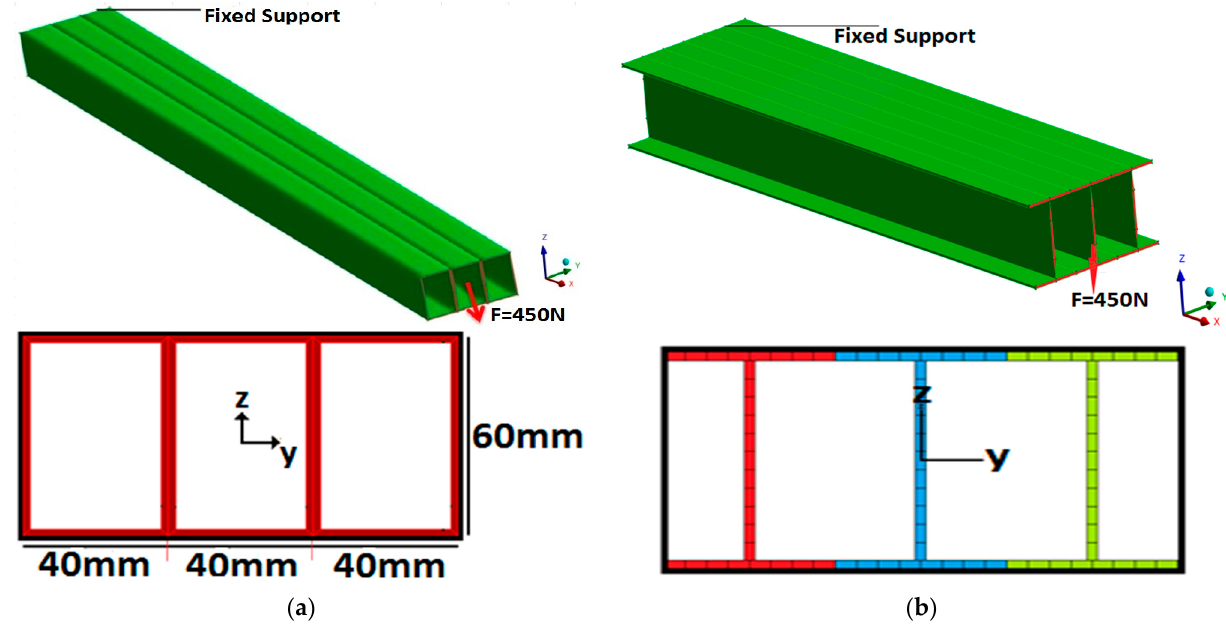
Figure 4. Finite element model geometry, applied loading, and boundary conditions: ( a ) “SSS” beam schematic, and ( b ) “III” beam schematic.